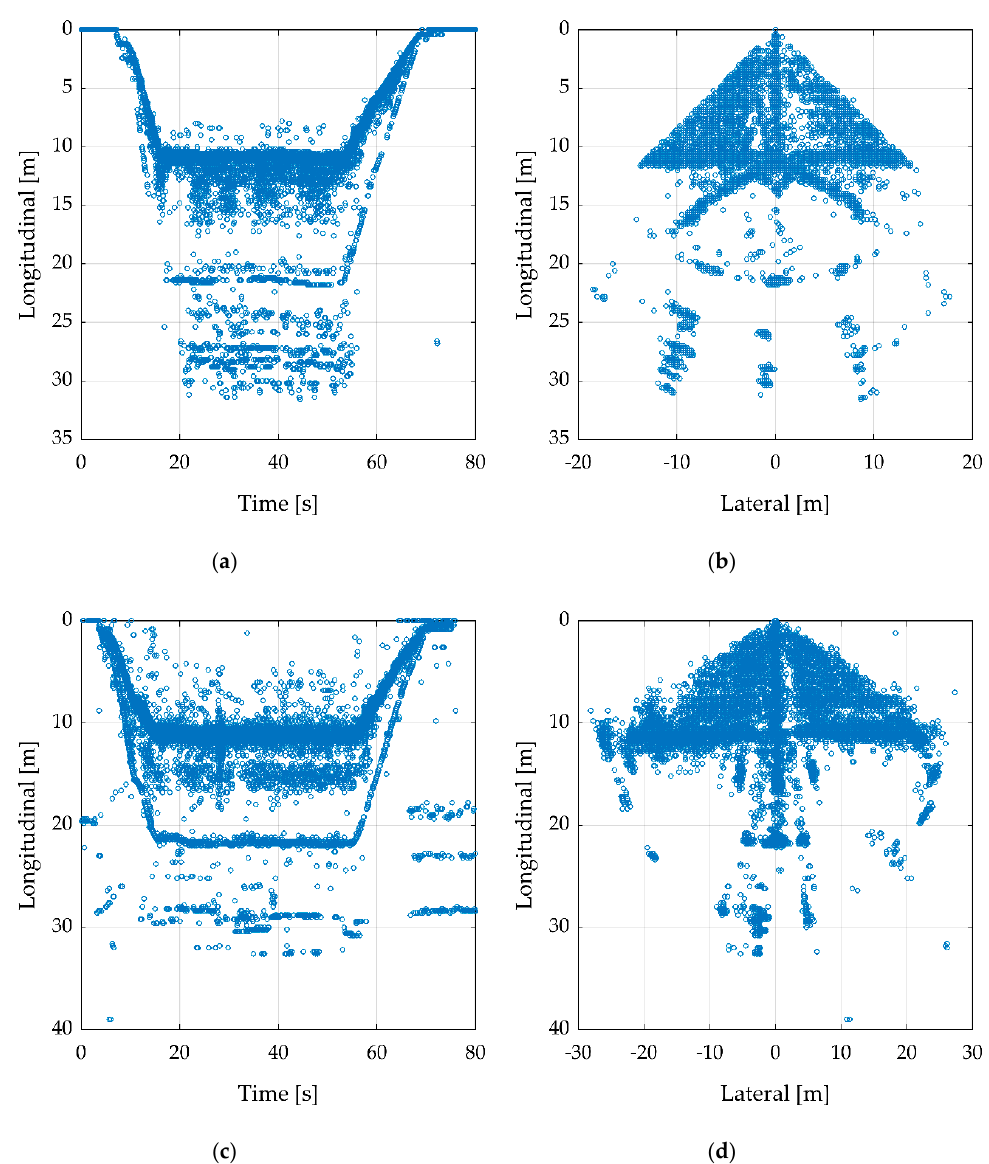
Figure 8. Recording flight in 10 m height over a corner cube reflector. Besides the real target in 10 m distance, several ghost clusters are visible. ( a , b ) Flight with ARS-404, to improve the figure the longitudinal axis was cut-off by 35 m and lateral axis by ±20 m. ( c , d ) Flight with ARS-408, to improve the figure, the longitudinal axis was cut-off by 40 m and lateral axis by ±30 m.